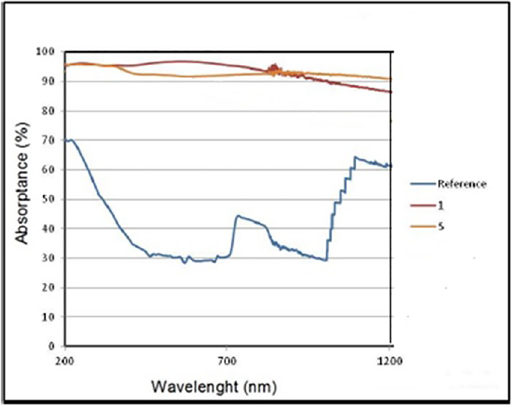
Figure 5. Spectroscopy of the substrate and the samples 1 and 5 coated.